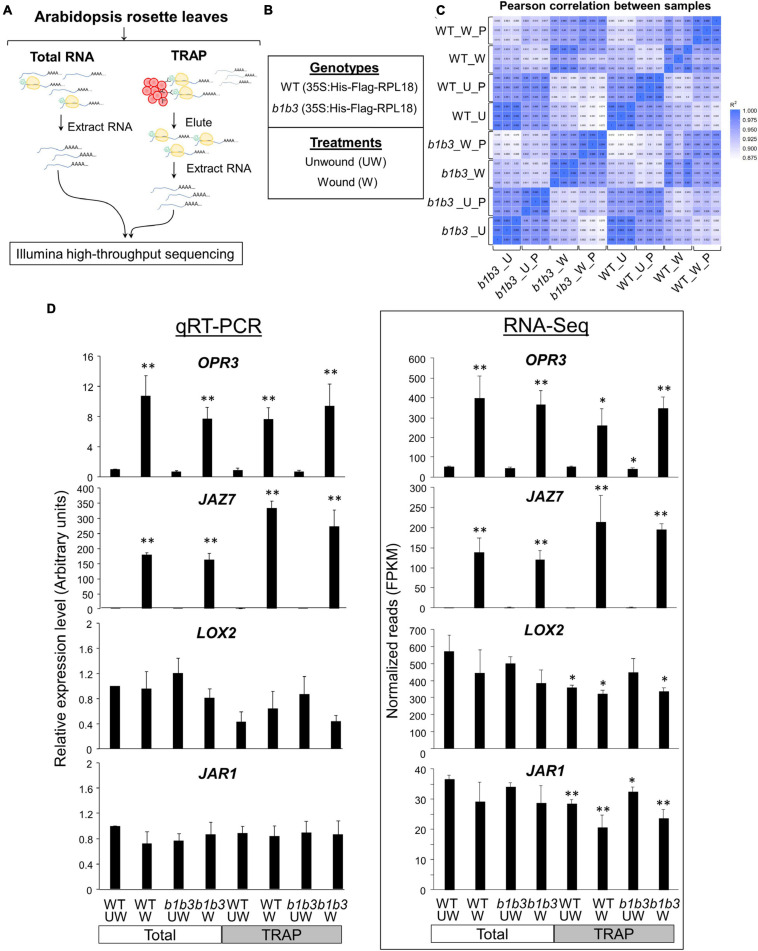
Overview of TRAP-Seq experiment and qPCR validation. (A) Schematics of total RNA-Seq and TRAP-Seq. Tissue samples were divided into two for total RNA extraction and TRAP. RPL18 of ribosomes (yellow) are epitope-tagged with 6X histidine (His)-FLAG (green), which is used to pull down by affinity to anti–FLAG-conjugated beads (red circles) to collect associated RNA. (B) Plant genotypes and treatments. (C) Pearson correlation between samples as an indicator of experiment reliability. The color gradient scale is shown where darkest blue indicates the R2 correlation value of 1 or perfect correlation. U, unwounded; W, wounded; P, polysomal. Each sample group labeled on the x- and y-axes consists of three sample replicates. Samples are ordered by experiment type. (D) Semiquantitative RT-PCR (qRT-PCR) (left) of OPR3, JAZ7, LOX2, and JAR1 genes compared with RNA-Seq data (right). Transcript abundance is indicated by FPKM (fragments per kilobase of transcript sequence per million base pairs sequenced). ACTIN8 was used as an internal reference gene, and the expression levels are displayed relative to the unwounded WT total RNA values. Data represent the mean + SE of three biological replicates. Asterisks denote statistical significance by Student t test compared to UW WT: ∗P < 0.05, ∗∗P < 0.01.